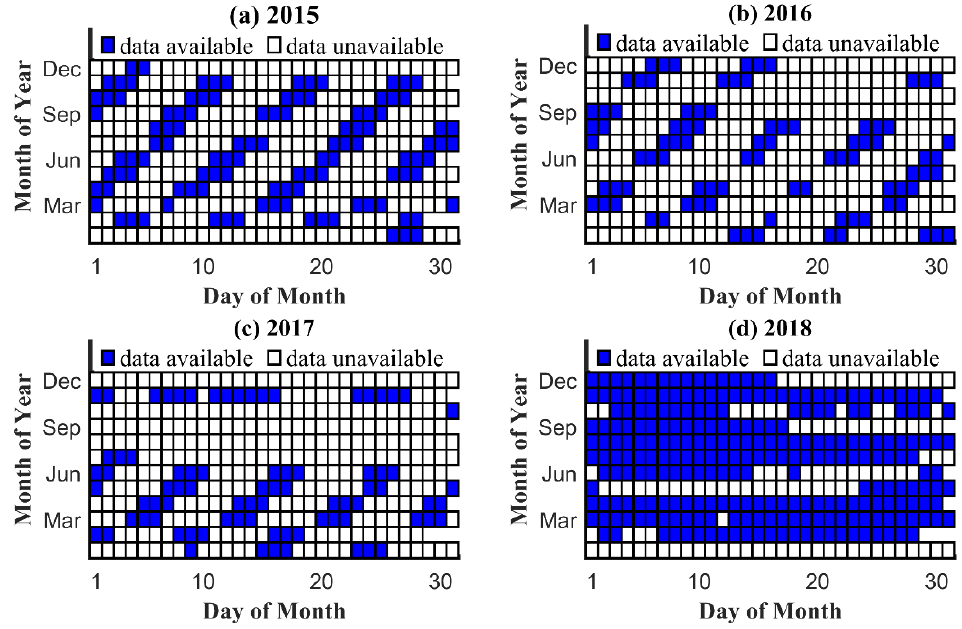
Figure 5. TDS ‐ 1 data availability in ( a ) 2015, ( b ) 2016, ( c ) 2017 and ( d ) 2018. The rectangles filled in blue represent the available TDS ‐ 1 data, whereas the rectangles without filled color represent the unavailability of TDS ‐ 1 data.